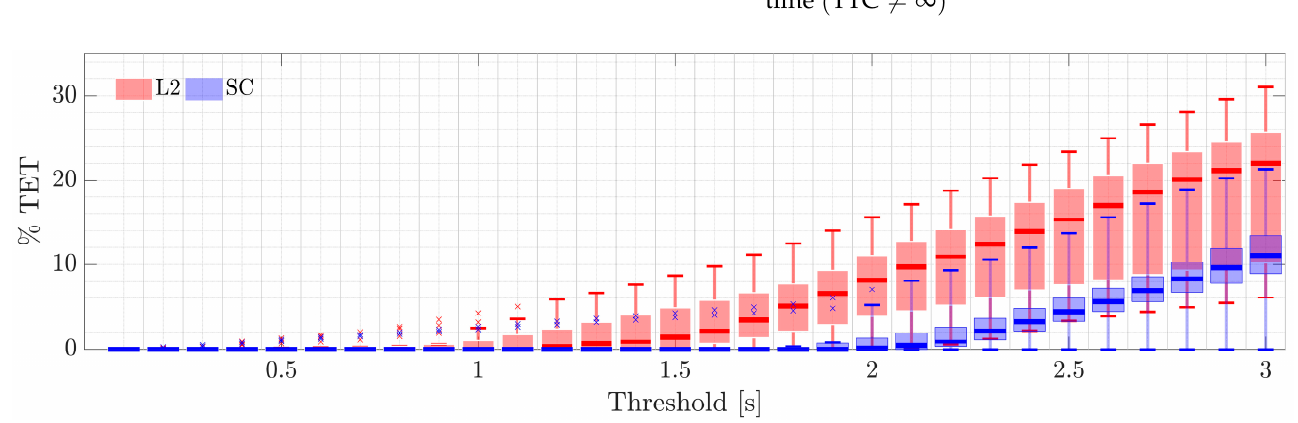
Figure 14. TET considering different TTC thresholds (between 0 and 3